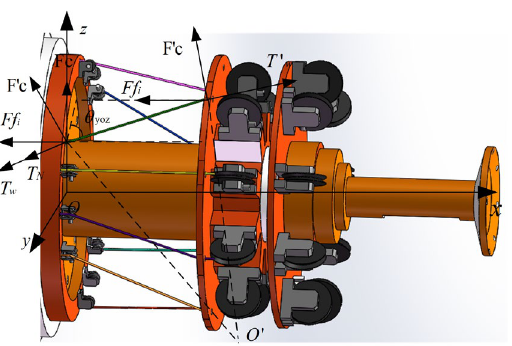
Figure 3. Force analysis of different twisting-deflection angles on the distribution reel.